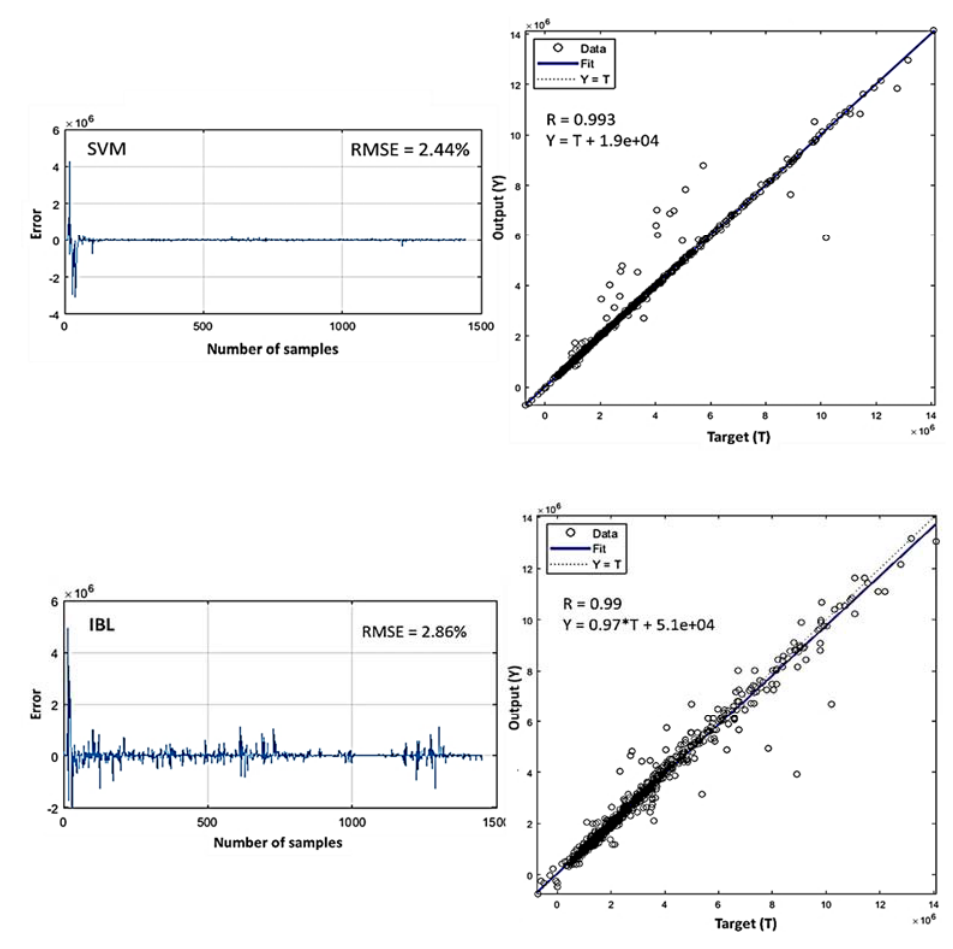
Figure 3. Model performance over the testing phase. Table 2. SVM performance with different Kernel types over the training and testing